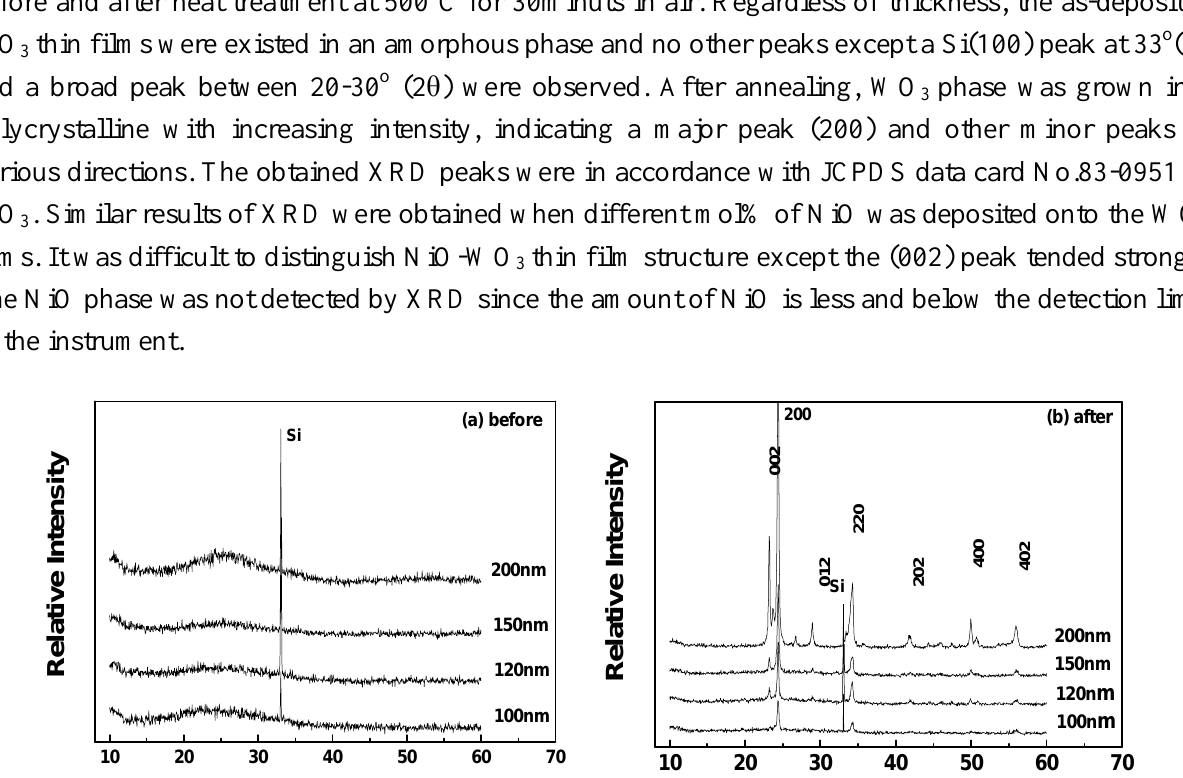
and NiO-WO thin films. 3 3